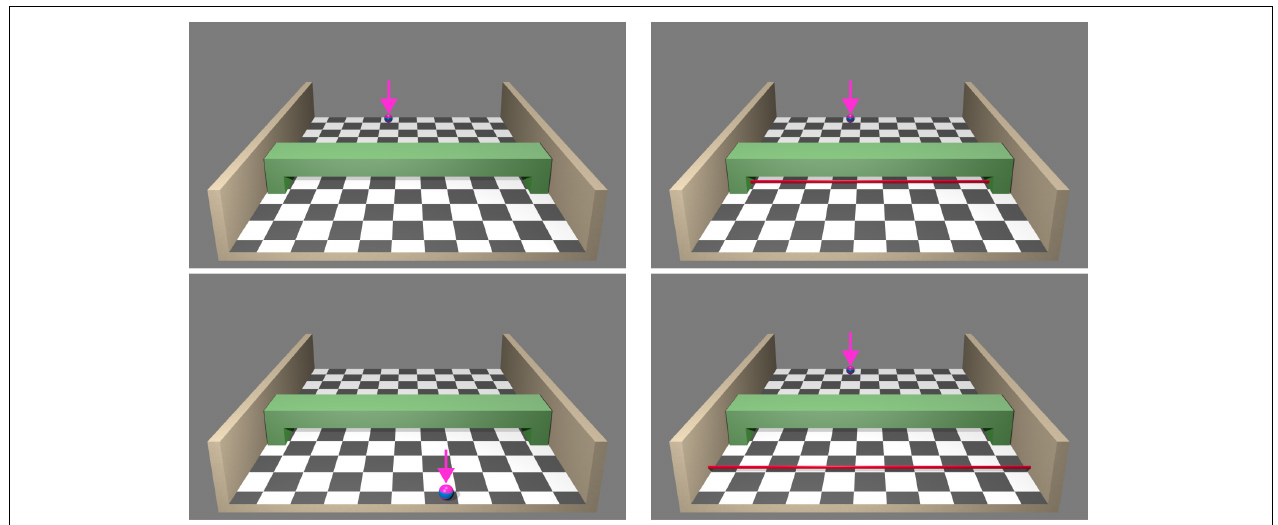
FIGURE 1 | Stimulus material used in experiments 1 (left) and 2 (right). A ball (highlighted with pink arrows for illustrative purposes but not shown during the experiment) moved from the top of a box toward the participant. During movement the ball was temporarily occluded by the green bridge and could reappear following the identical or a divergent trajectory (experiment 1). Visual stimuli could be displayed in pseudo-3D and real-3D (varied session-wise and counterbalanced across participants). In both sessions stimuli were presented on a stereoscopic screen. In the real-3D sessions images had a spatial offset so that a 3D impression occurred when participants wore polarised glasses. There was no offset in pseudo-3D sessions. Auditory co-stimulation was a moving white noise either with the same or opposite direction as the visual trajectory. In addition, a visual-only condition was introduced. Participants detected when the ball reappeared (experiment 1, temporal detection). In experiment 2 the ball did not reappear after occlusion. Participants’ task was to indicate when the ball would have reached the red bar at a near or far position (temporal